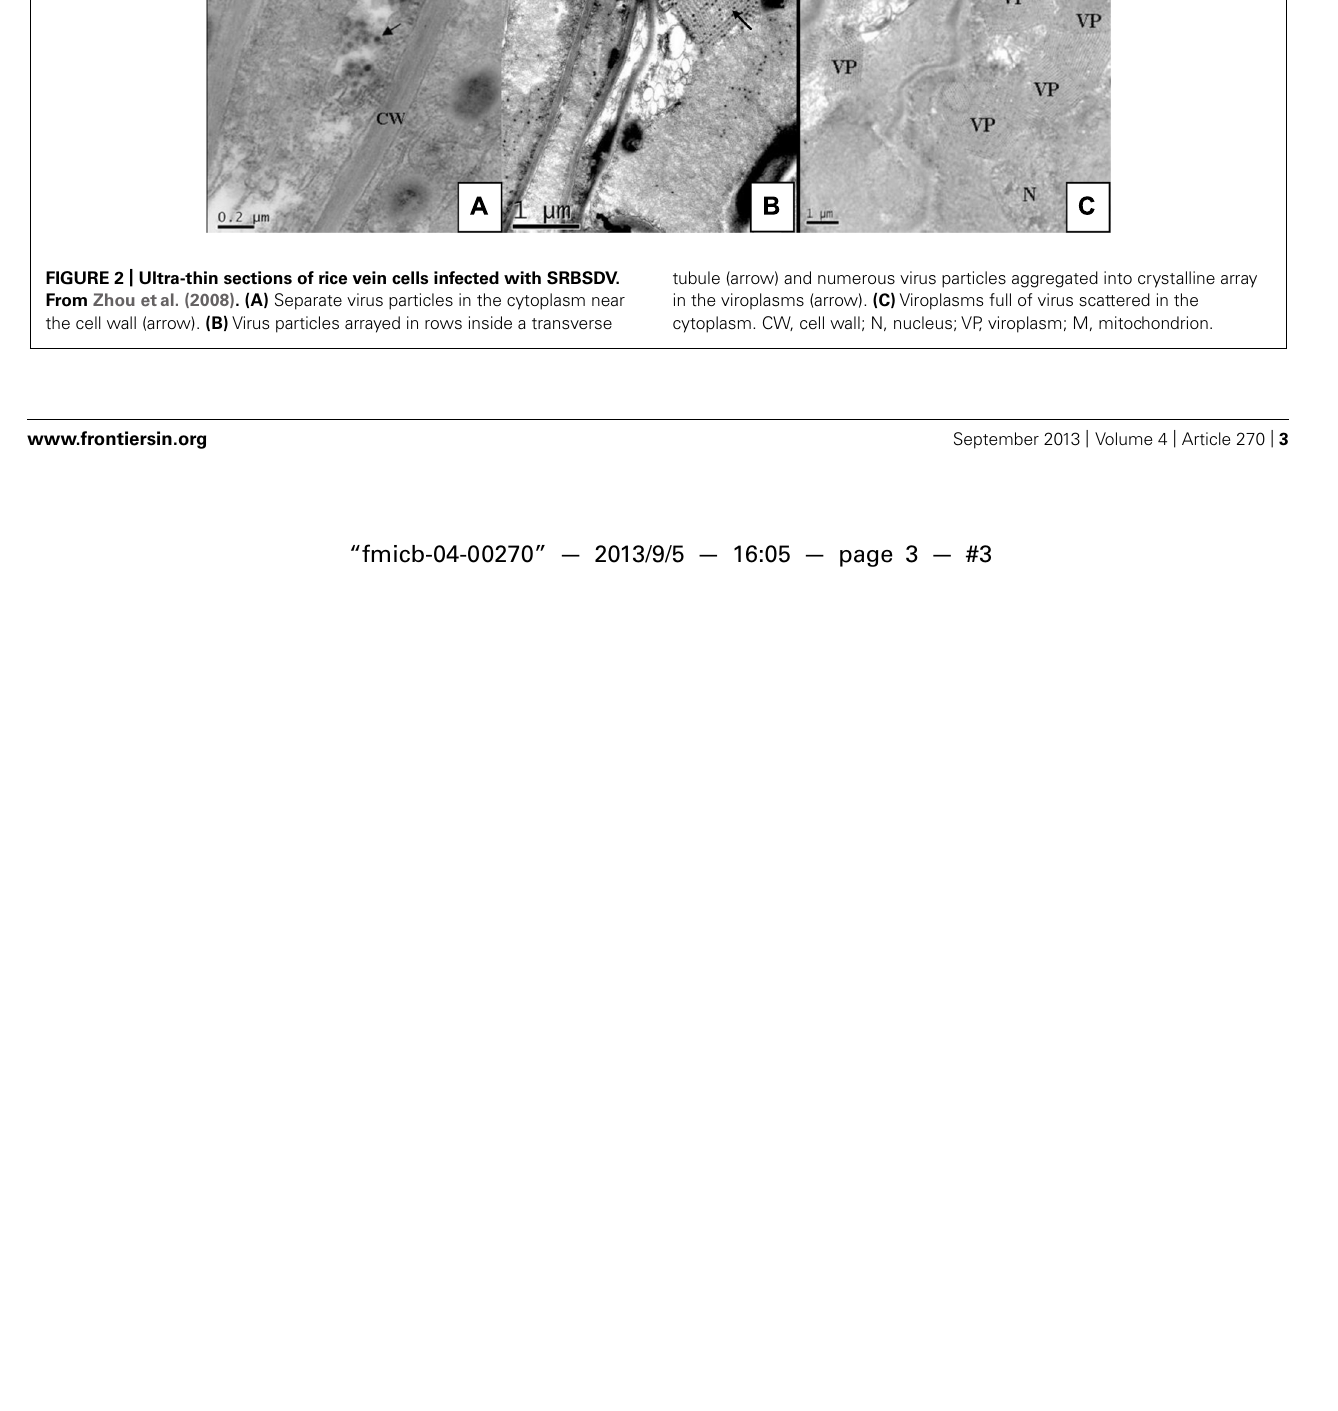
FIGURE 2 | Ultra-thin sections of rice vein cells infected with SRBSDV. From Zhou etal. (2008). (A) Separate virus particles in the cytoplasm near the cell wall (arrow). (B) Virus particles arrayed in rows inside a transverse